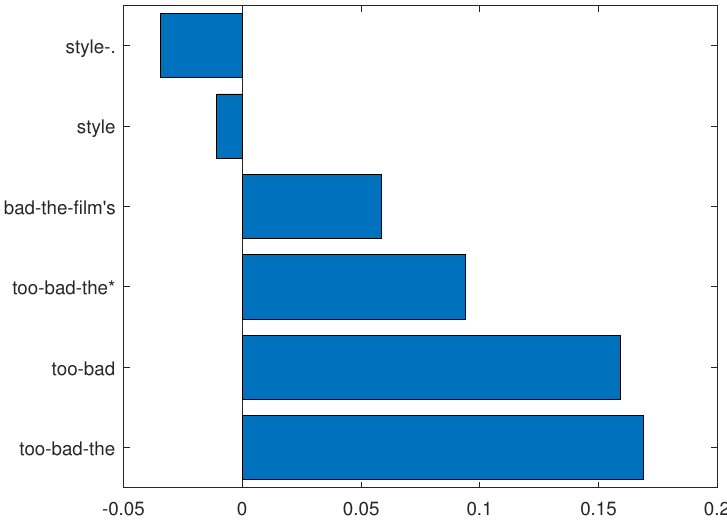
Figure 7. N-grams determined from R 26 and the following “tweet” (in the testing set): “it is just too bad the film’s story does not live up to its style”. On the vertical axis are represented the n-grams classified according to their linear contribution. Negative values are against the final classification, while positive values are in its favor. The sum of the n-grams linear contributions is